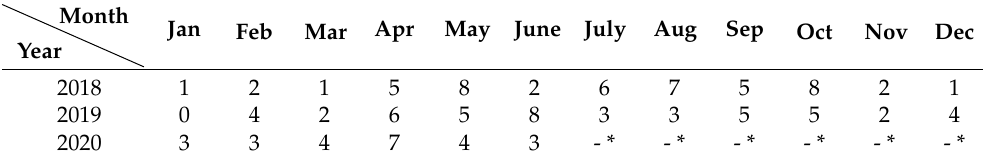
Table 1. Monthly distribution of 119 Sentinel-2 L2A scenes available from 1 January 2018